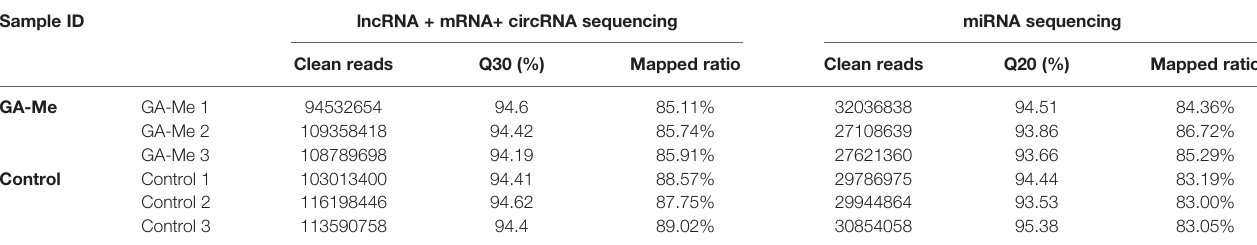
TABLE 2 | Deep RNA sequencing analysis of different groups. Sample